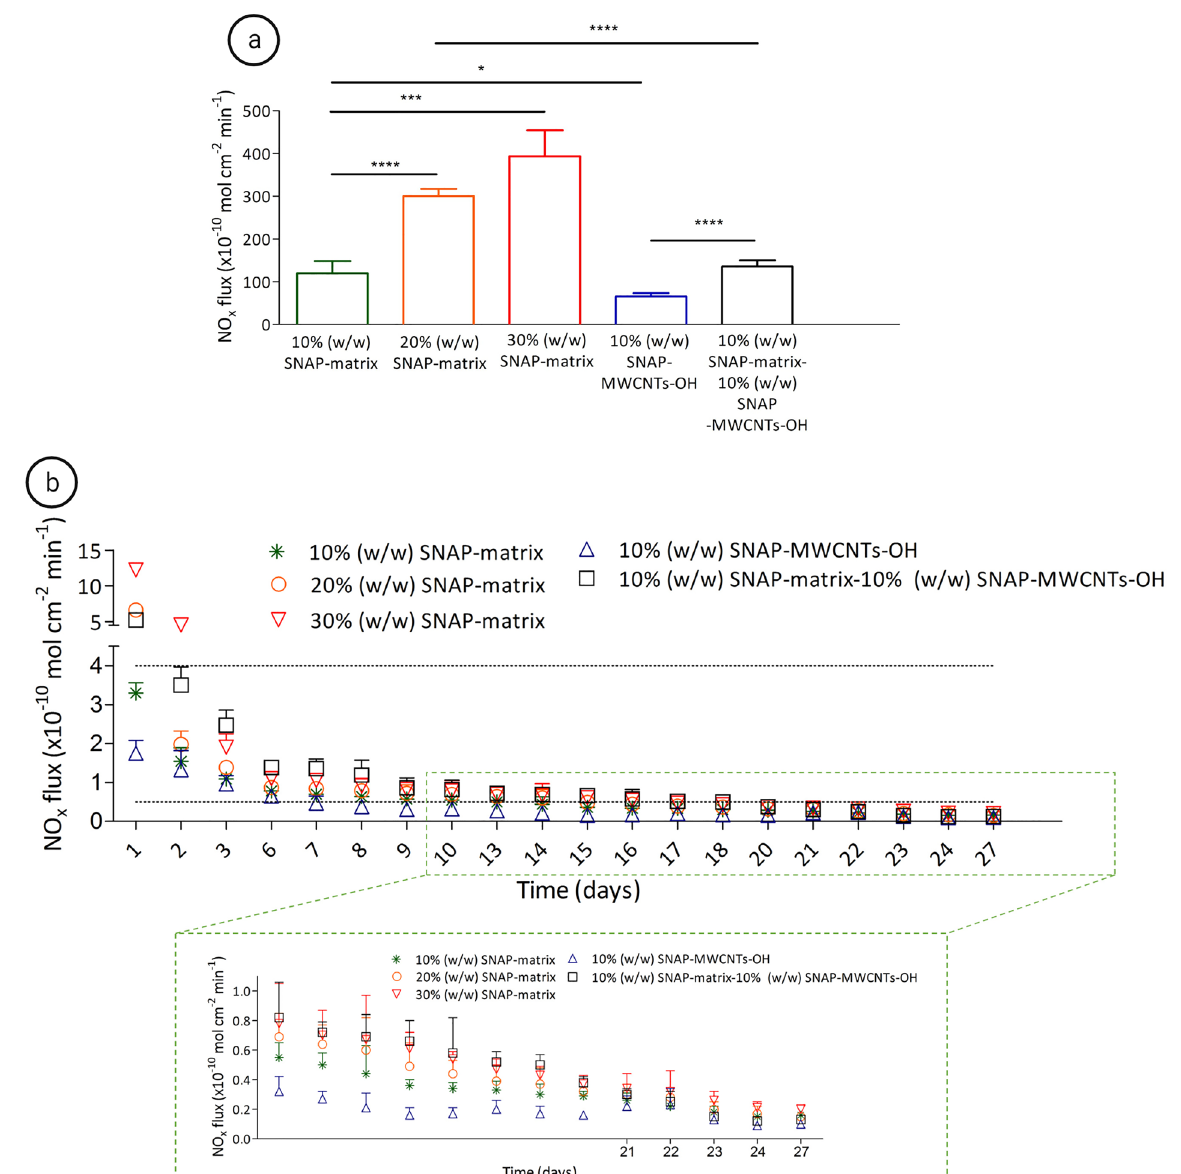
Figure 4. NO release profile from 3D printed grafts after coating. NO flux in PBS with 100 µM EDTA at different time points from 10%, 20% and 30% (w/w) SNAP- matrix, 10% (w/w) SNAP-MWCNT-OH and 10% (w/w) SNAP-matrix-10% (w/w) SNAP-MWCNT-OH. Part a shows the NO flux after 1 h, part b for day 1–27. The zone between black dashes represents the physiological range of NO flux (0.5–4 × 10–10 mol cm −2 min −1 ). Data are expressed as mean ± SD (n = 6). *P < 0.05. **P < 0.01. ***P < 0.001. ****P <